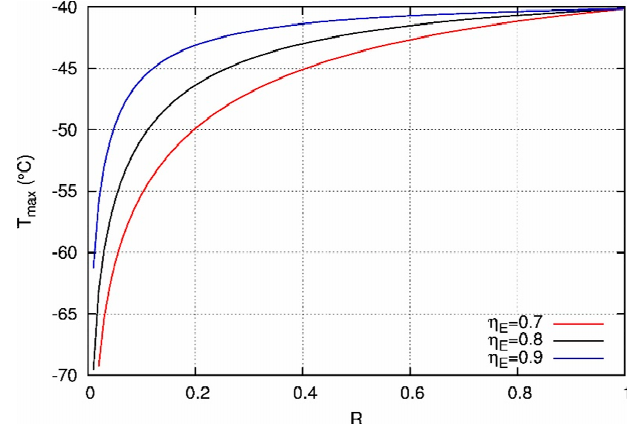
Figure 6. Dependence of the maximum temperature at which contrails are possible, 𝑇 (cid:3040)(cid:3028)(cid:3051) , on the ratio R for parallel-hybrid-electric propulsion. Parameters are as in Figure 4.